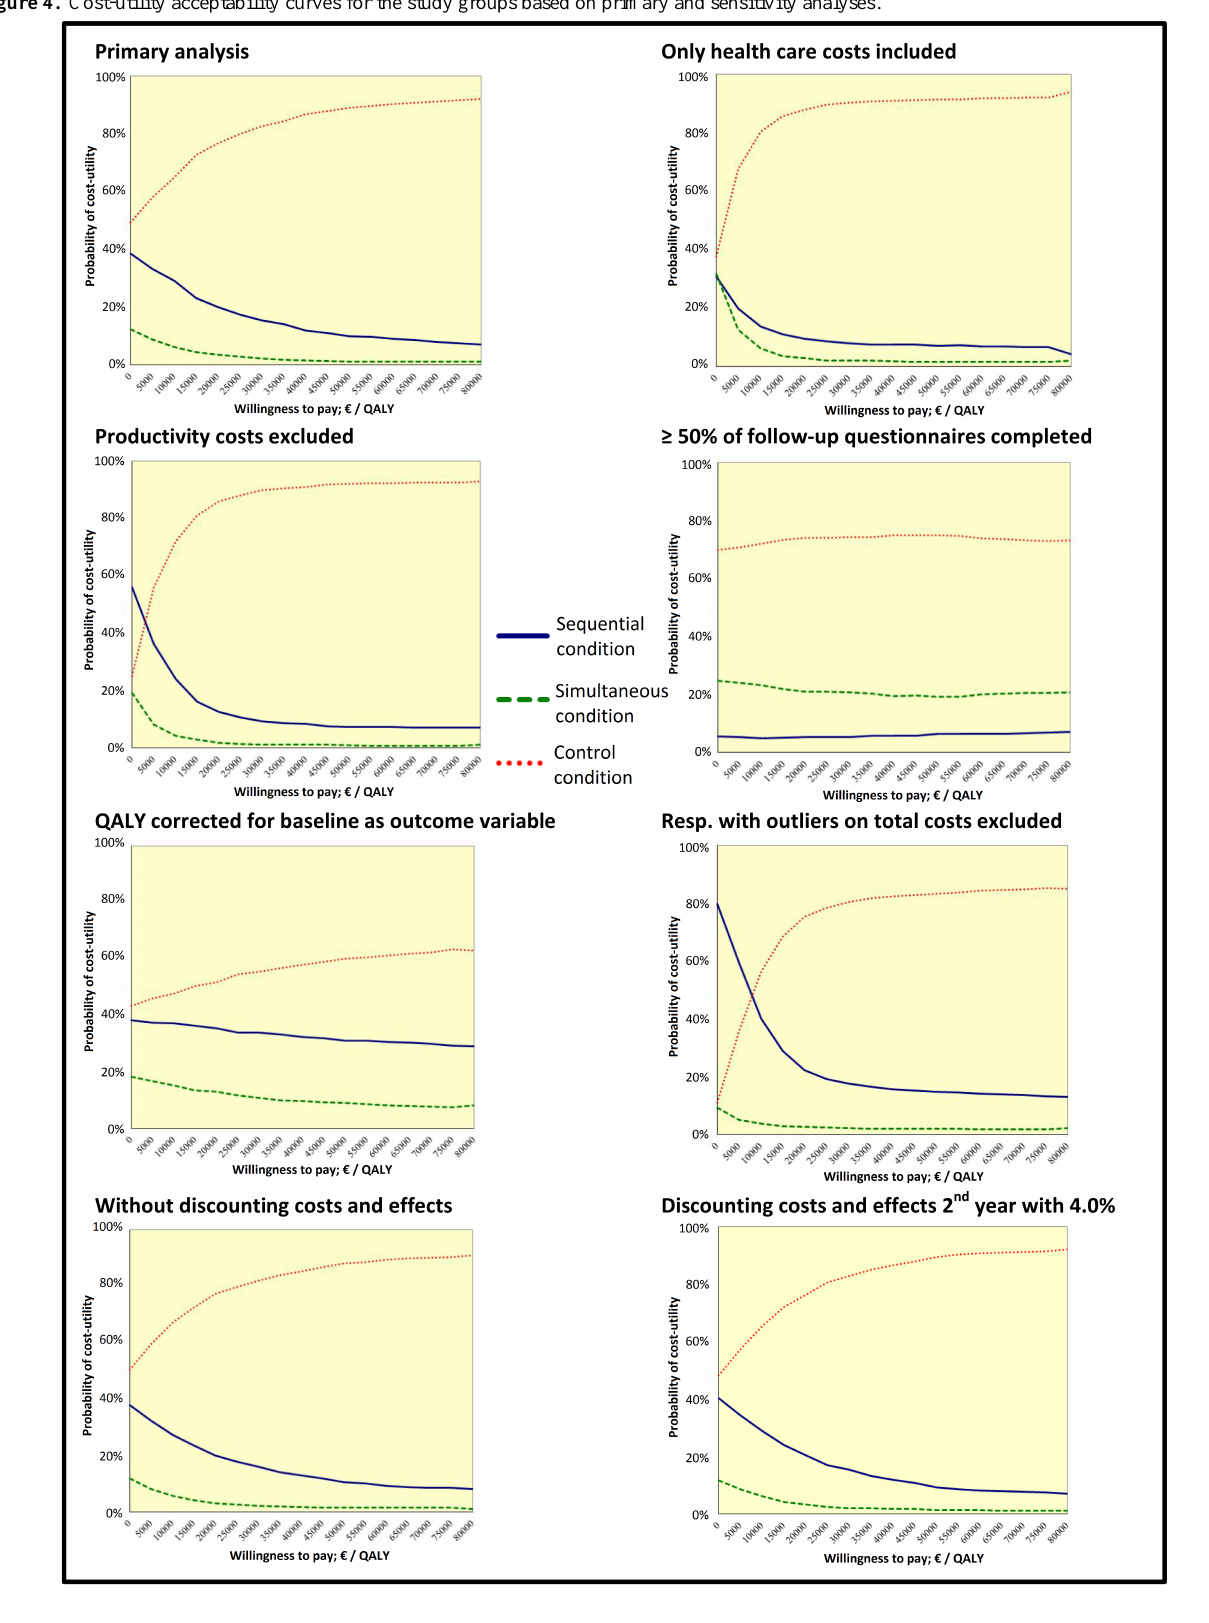
Figure 4. Cost-utility acceptability curves for the study groups based on primary and sensitivity